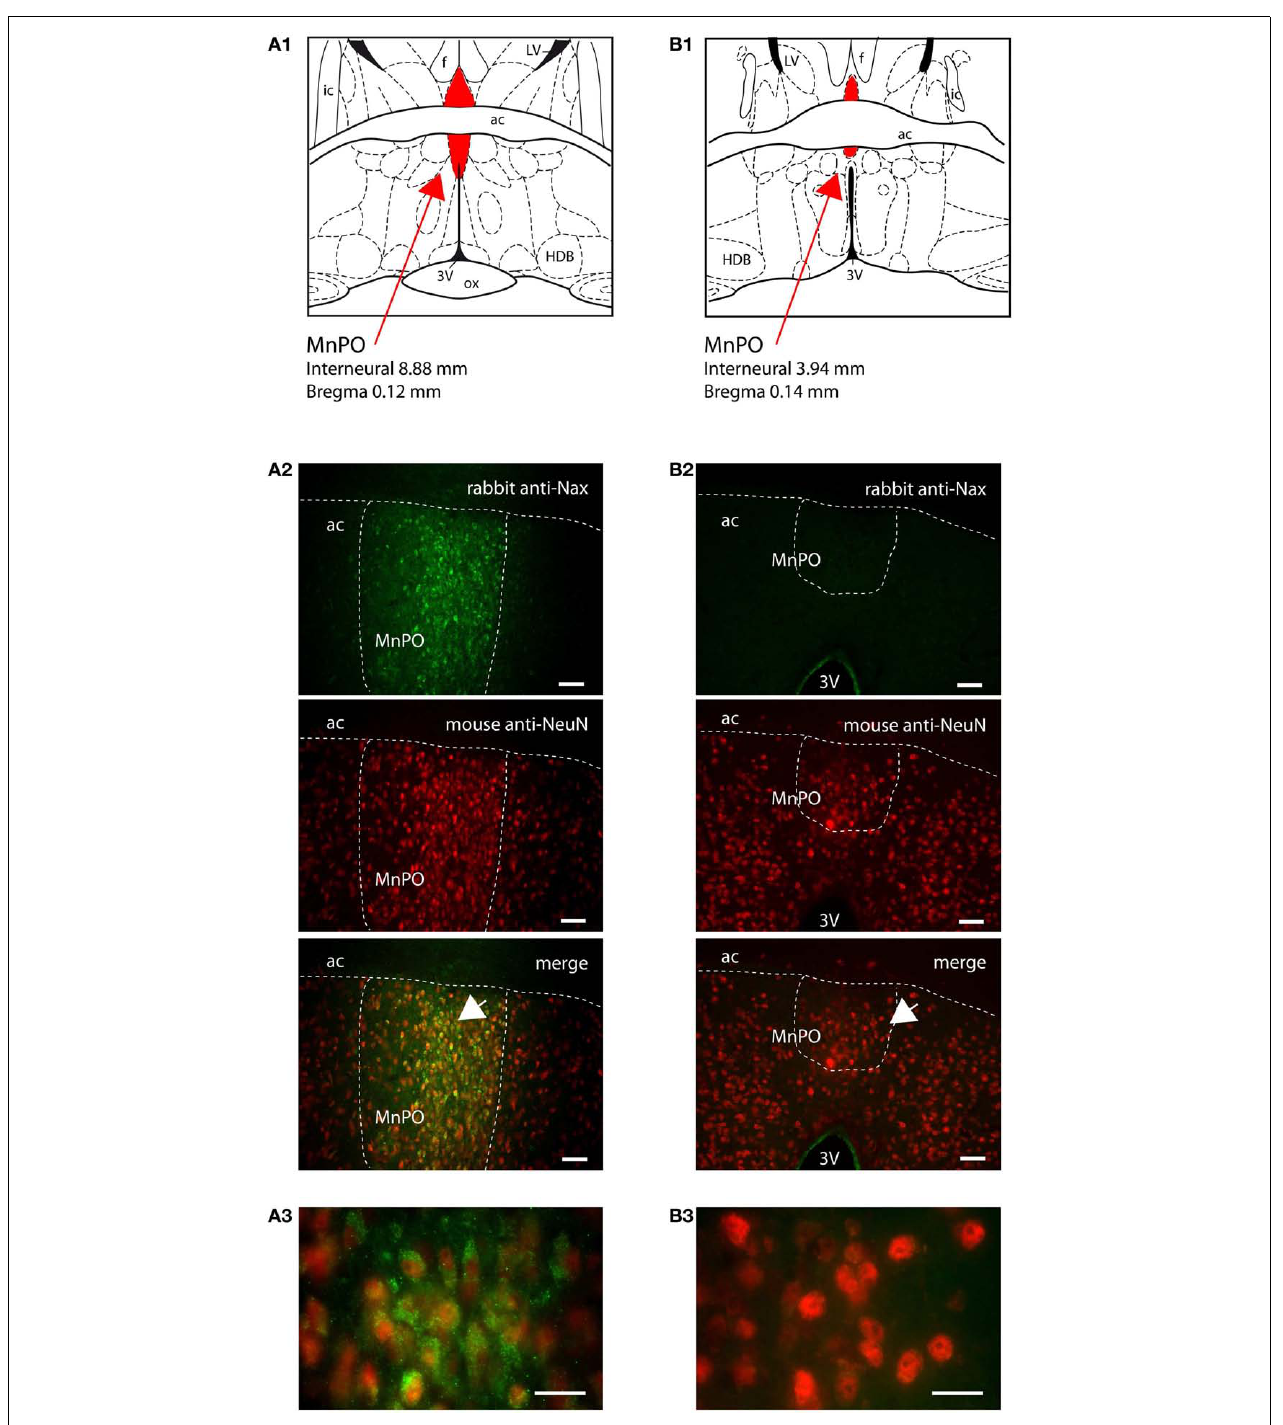
immunostaining (red).The arrow head points the top-right corner of the inset that represents a high magnification zone of the ventral MnPO; scale bar: 20 µ m. Note the colocalization of the fluorescent Na X and NeuN immunostaining. (B1) Schematic illustration of the mouse MnPO (red filling). (B2) Representative picture showing that fluorescent Na X immunostaining was restricted to the cell layer boarding the third ventricle in the mouse; scale bar: 50 µ m.The arrow head points the top-right corner of the inset that represents a high magnification zone of the ventral MnPO in the rat (A3) and in the mouse (B3) ; scale bar: 20 µ